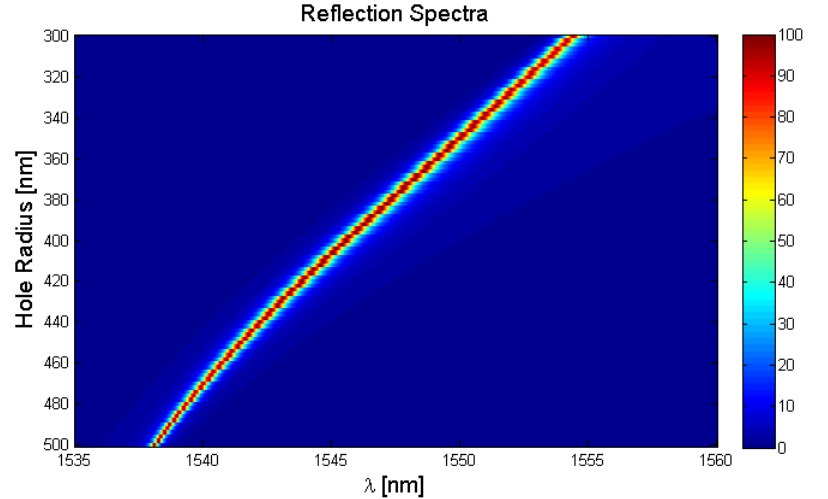
Figure 4. Spectral response of the GMRF as a function of holes